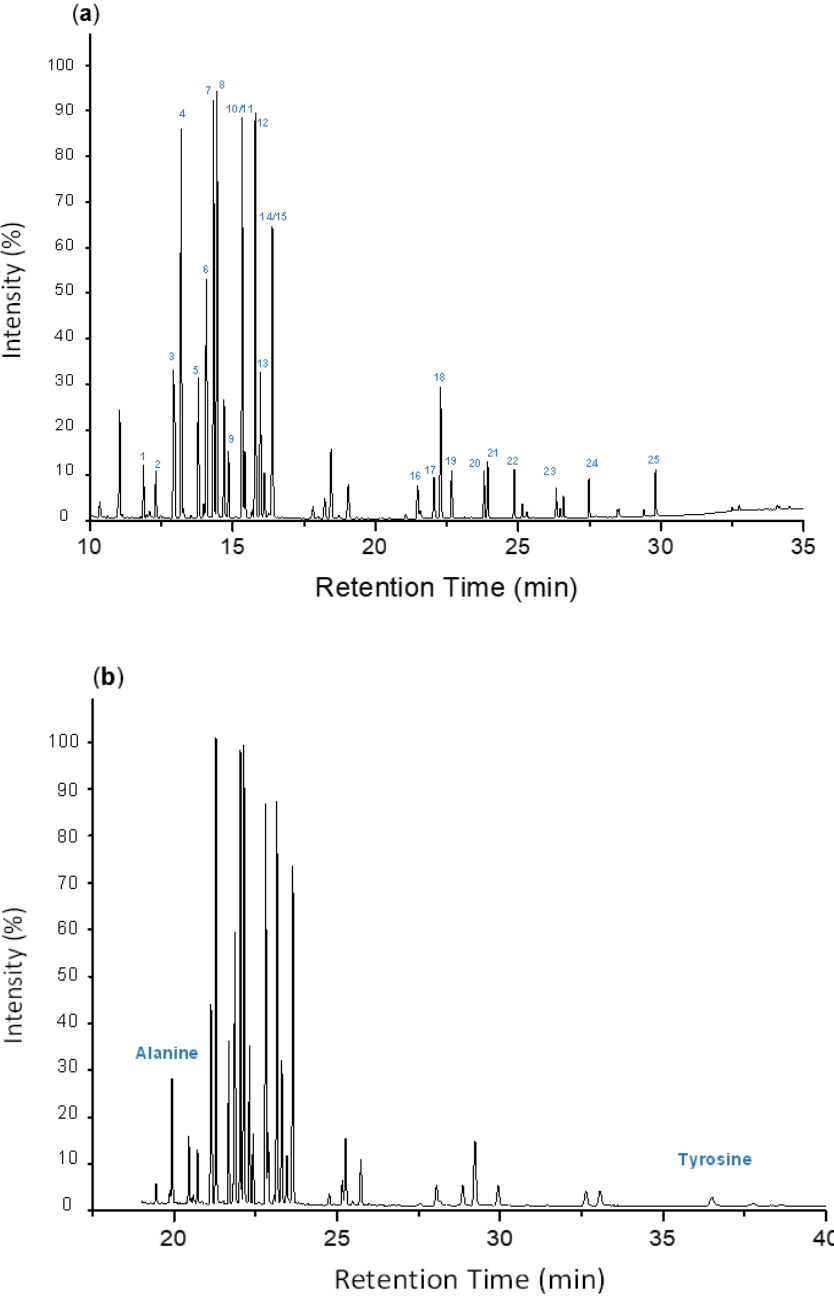
Figure 3. Totally resolved TIC of 31 amino acids derivatized with MTBSTFA separated using: ( a ). A laboratory temperature program: Oven temperature was set at 90 °C raised up to 180 °C at a rate of 6 °C/min, and then held for 5 min. Afterwards, temperature was raised up to 300 °C at a rate of 10 °C/min, and then held for 8 min. 1. Alanine; 2. Glycine; 3. 2-Aminoisobutyric acid, Sarcosine; 4. 2-Aminobutyric acid; 5. β -Alanine; 6. 3-Aminobutyric acid, 3-Aminoisobutyric acid, Valine; 7. Norvaline; 8. Isovaline; 9. Leucine; 10. Alloisoleucine; 11. Isoleucine; 12. Norleucine; 13. ɣ -Aminobutyric acid; 14. Proline; 15. β -Leucine; 16. Methionine; 17. Serine; 18. Isoserine; 19. Threonine; 20. Phenylalanine; 21. Homoserine; 22. Aspartic acid; 23. Glutamic acid; 24. Lysine; 25. Tyrosine. ( b ). SAM GC-MS separation program validated for in situ missions. Oven temperature was set at 34 °C for 6 min, then heated up to 185 °C at a rate of 10 °C/min, and held for 20 min.